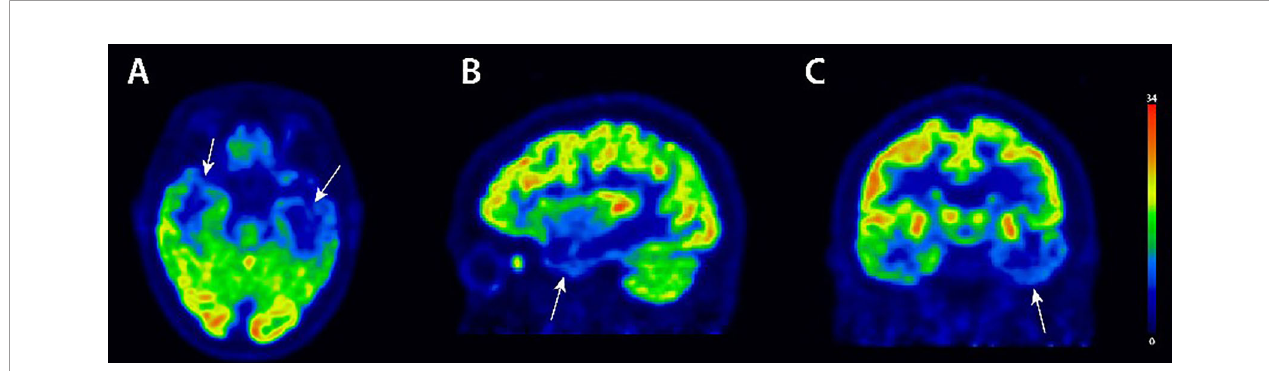
FIGURE 1 | 18F-FDG PET/CT imaging. 18F-FDG-PET images in axial (A) , sagittal (B) and coronal (C) view showing asymmetric hypometabolism in both temporal lobes (arrows), predominantly in the anterior left temporal lobe. 18F-FDG-PET/CT, 18F- fl uorodeoxyglucose (18F-FDG) Positron Emission Tomography (PET)/ computed tomography (CT)